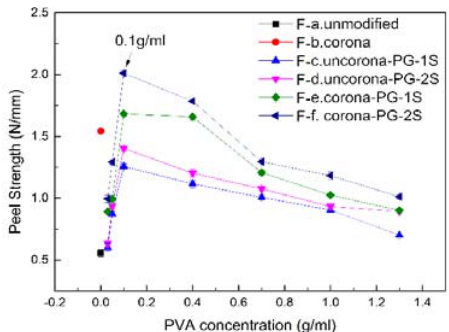
Figure 4. Peel Strength of the composite with different polyvinyl alcohol (PVA) concentration of the six methods.